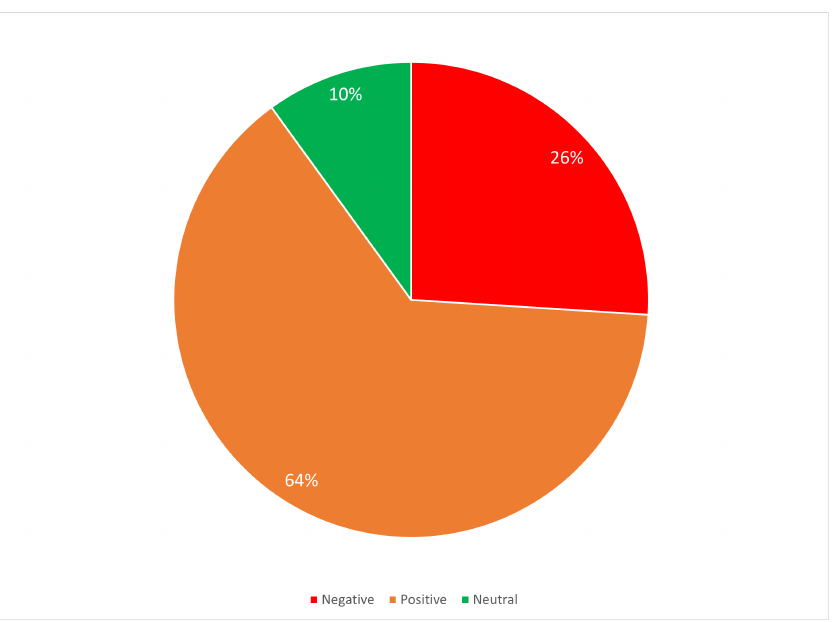
Figure 12. Sentiment ratio, media